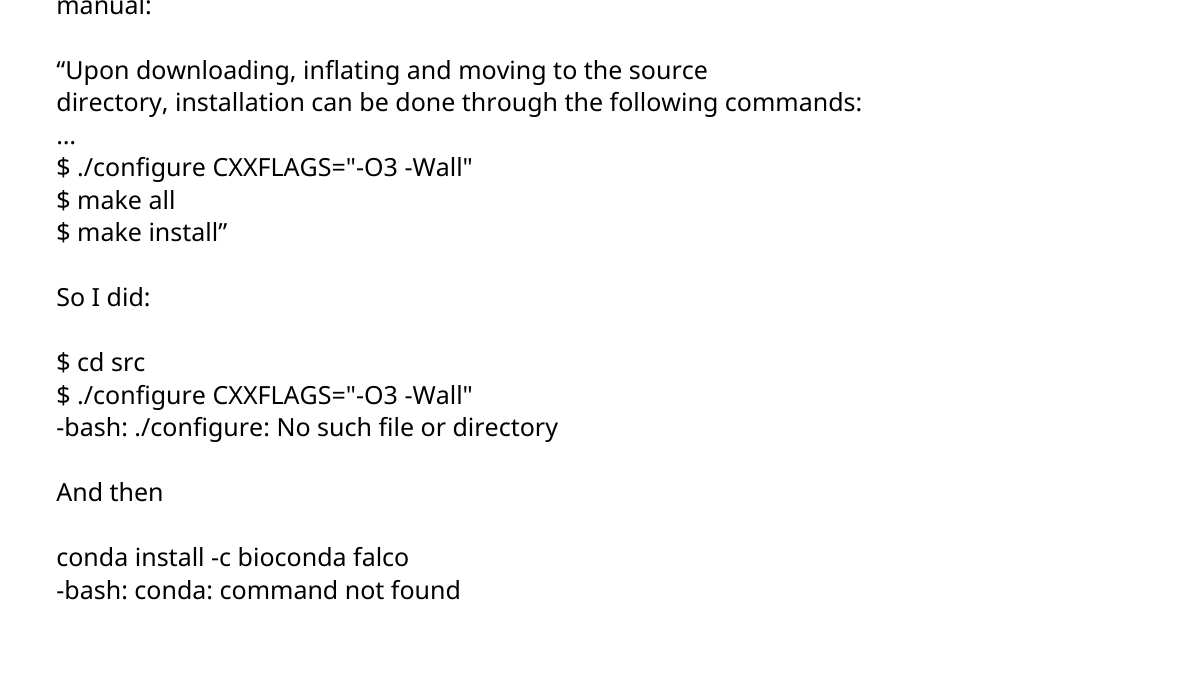
() Article titles: should verbs and key nouns in article titles have a leading uppercase letter, as in, e.g., ref 5, or should they not, as in ref